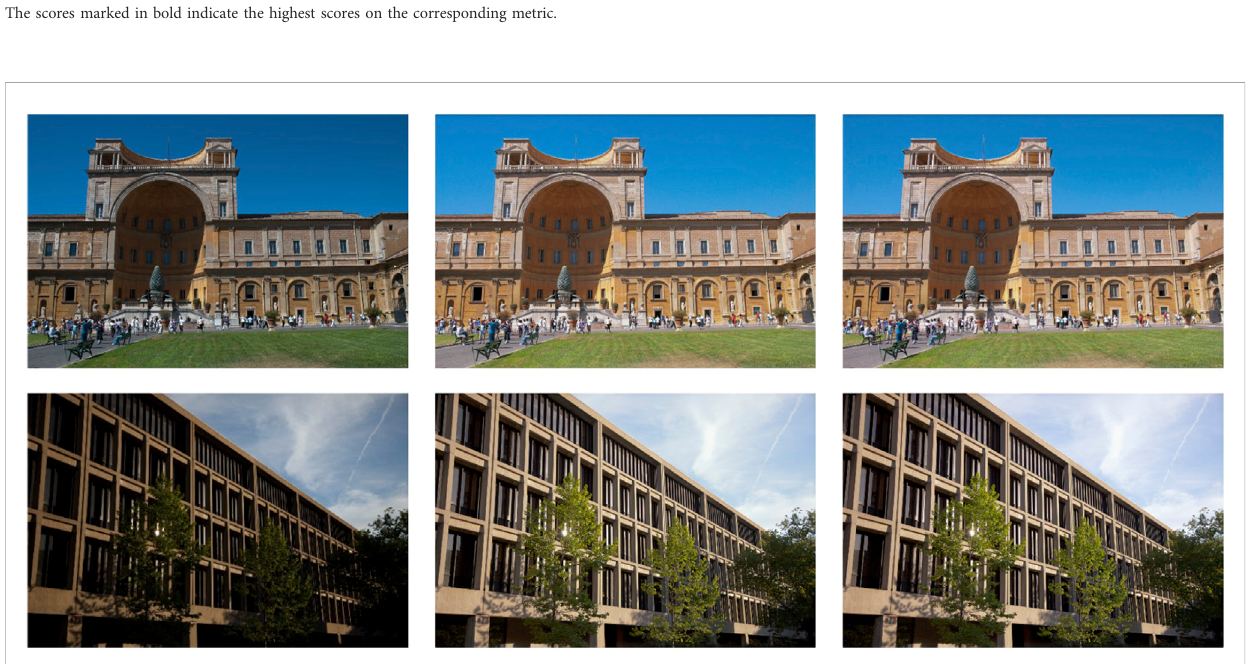
FIGURE 6 Qualitative comparison of the enhancement results without and with Reverse Domain-Distance Guided strategy. The texture and details are better reconstructed with the propsed